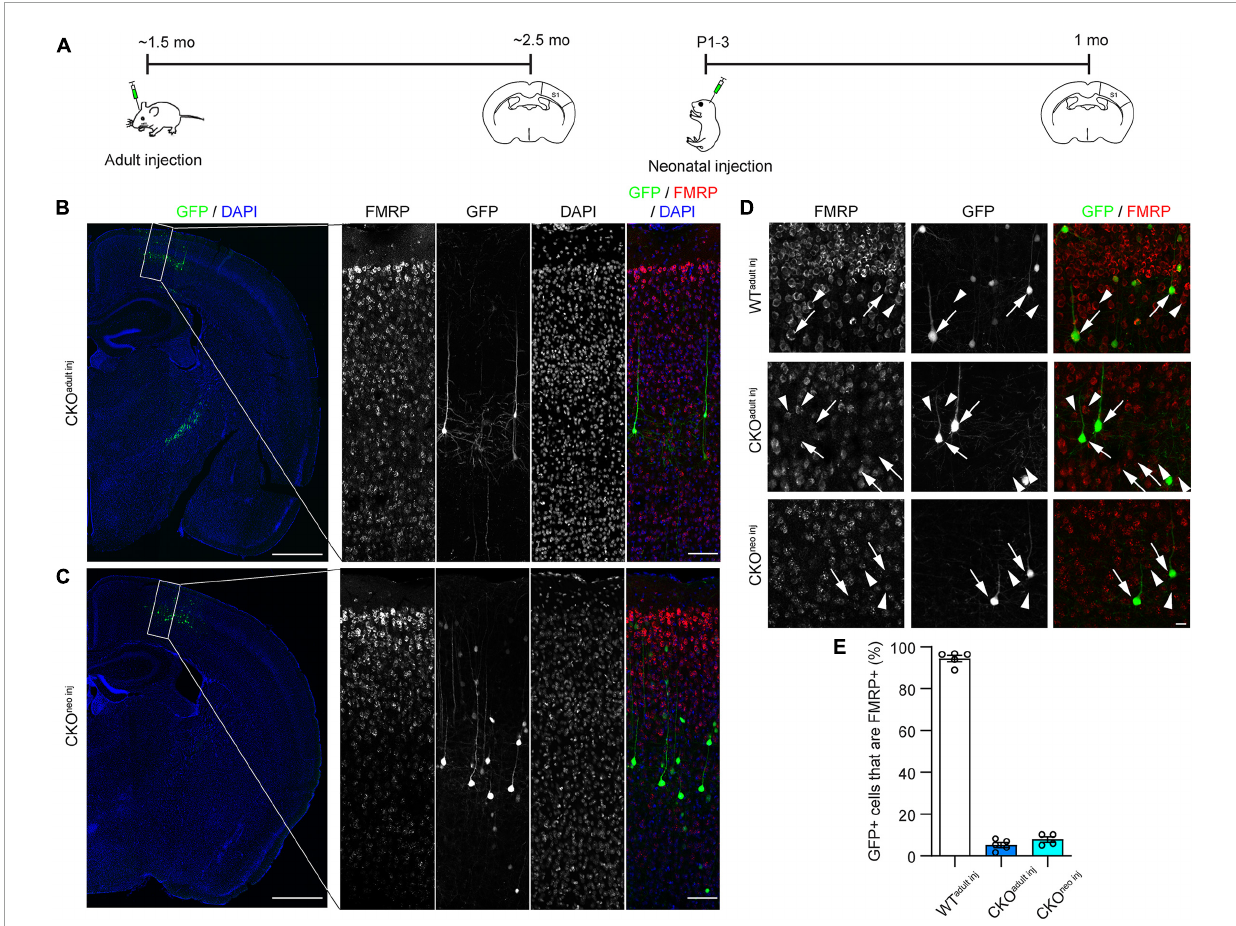
FIGURE1 Cre-lox recombination strategy successfully eliminates Fragile X Messenger Ribonucleoprotein (FMRP) from individual infected cells. (A) Timeline of virus injection and histology. (B) Left: Example of Cre-dependent green fluorescent protein (GFP) expression and Fmr1 knockout (KO) in a sparse subset of S1 L5 PyrNs of a Fmr1 conditional knockout (CKO) adult inj mouse. Scale bar: 500 µ m. Right: Enlarged view of the rectangular region in the left panel showing FMRP and GFP expression. Scale bar: 100 µ m. (C) Examples of Fmr1 KO in a CKO neo inj mouse, with the same magnification and arrangement as in (B) . (D) FMRP and GFP expression in WT adult inj (top), CKO adult inj (middle), and CKO neo inj (bottom) mice imaged with confocal microscopy. Arrows: GFP+ cells; arrowheads: GFP-/FMRP+ cells. Scale bar: 20 µ m. (E) Percentages of cells co-expressing GFP and FMRP